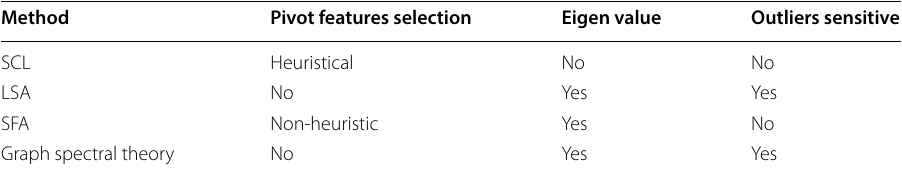
Table 2 Overview of methods (for an explanation see text)